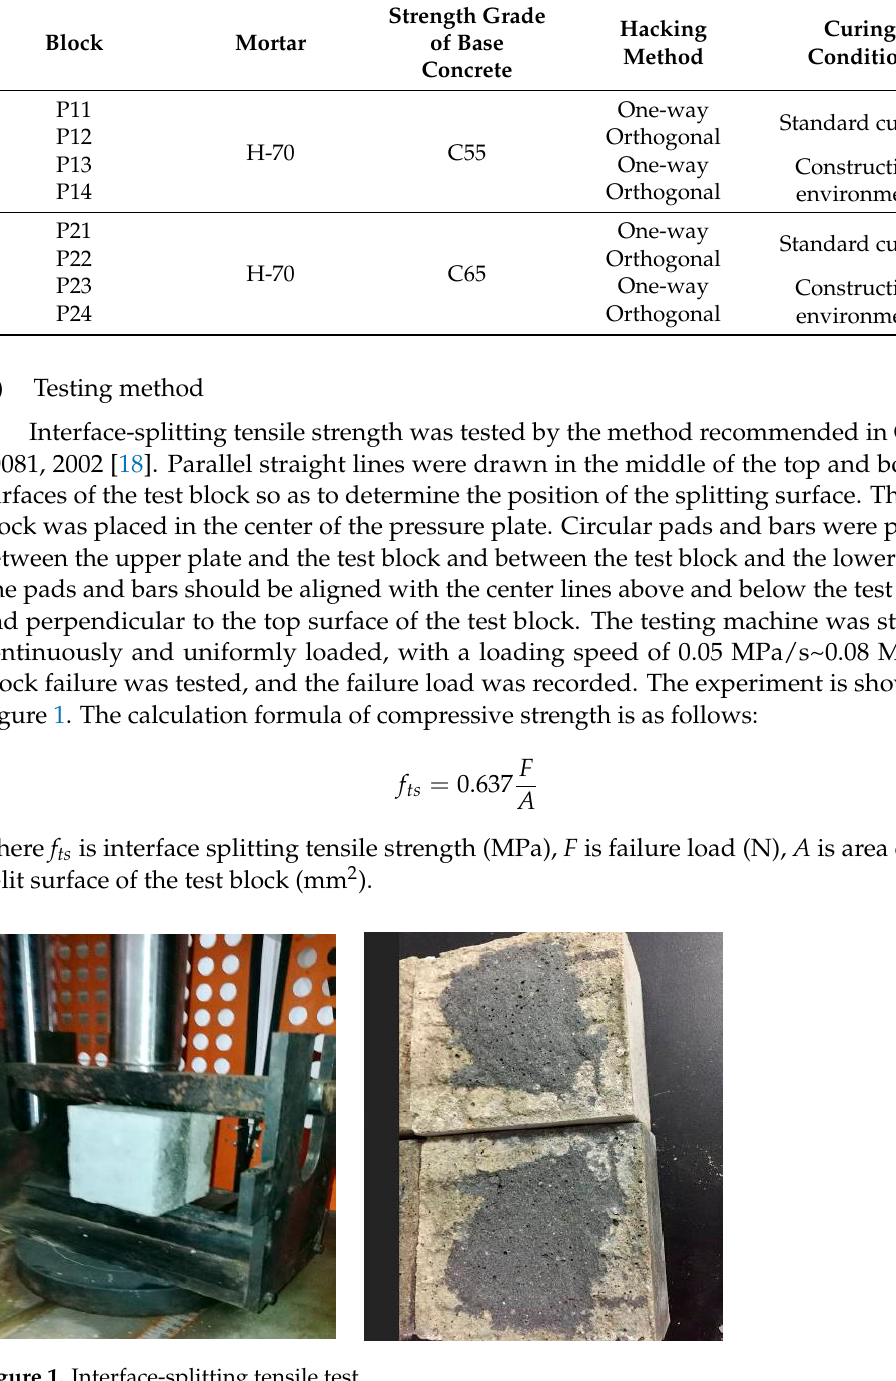
Figure 1. Interface-splitting tensile